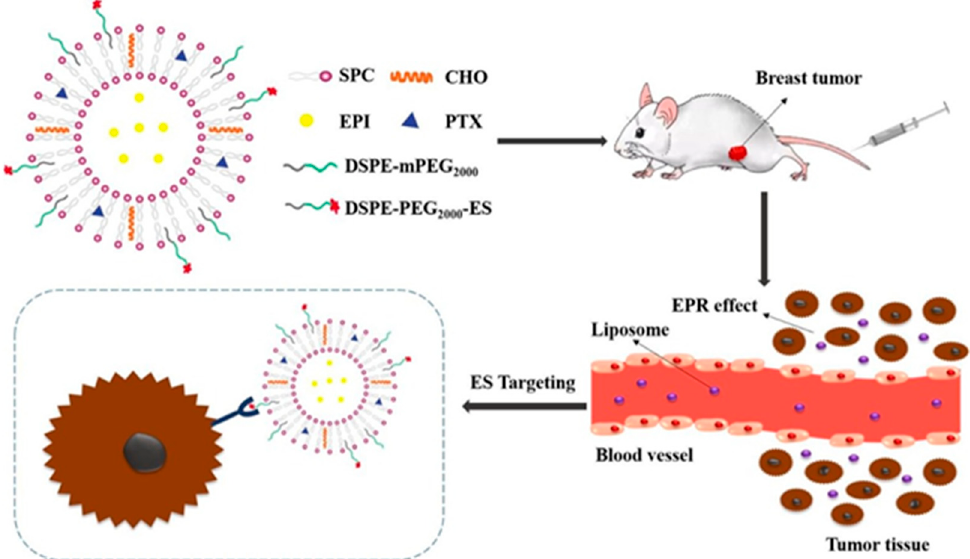
Figure 2. Schematic representation of the liposomal drug delivery carrier system and treatment. The overexpressed estrogen receptors on cancer cells were targeted by estrone in vitro and in vivo. Reproduced with permission from ref. [88] Copyright © 2020, Elsevier.